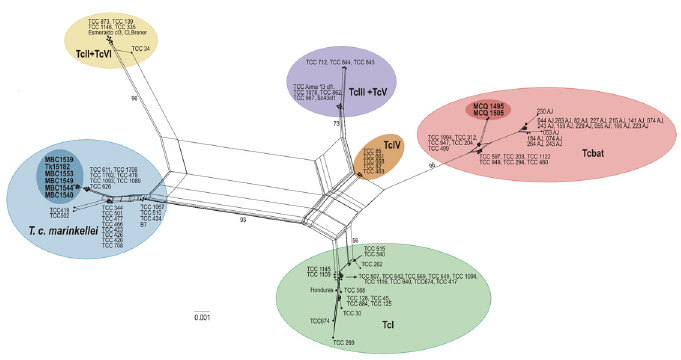
Fig 1. Network genealogy using partial 18S rRNA gene sequences from eight new trypanosomes characterised in this study (in bold) plus 70 other sequences from all DTUs (TcI-TcVI and Tcbat) of T . cruzi and 22 sequences from T . c . marinkellei . Network constructed with the NeighborNet algorithm excluding all conserved sites and with uncorrected p-distance. Numbers in nodes correspond to bootstrap support values using the same parameter optimized for network